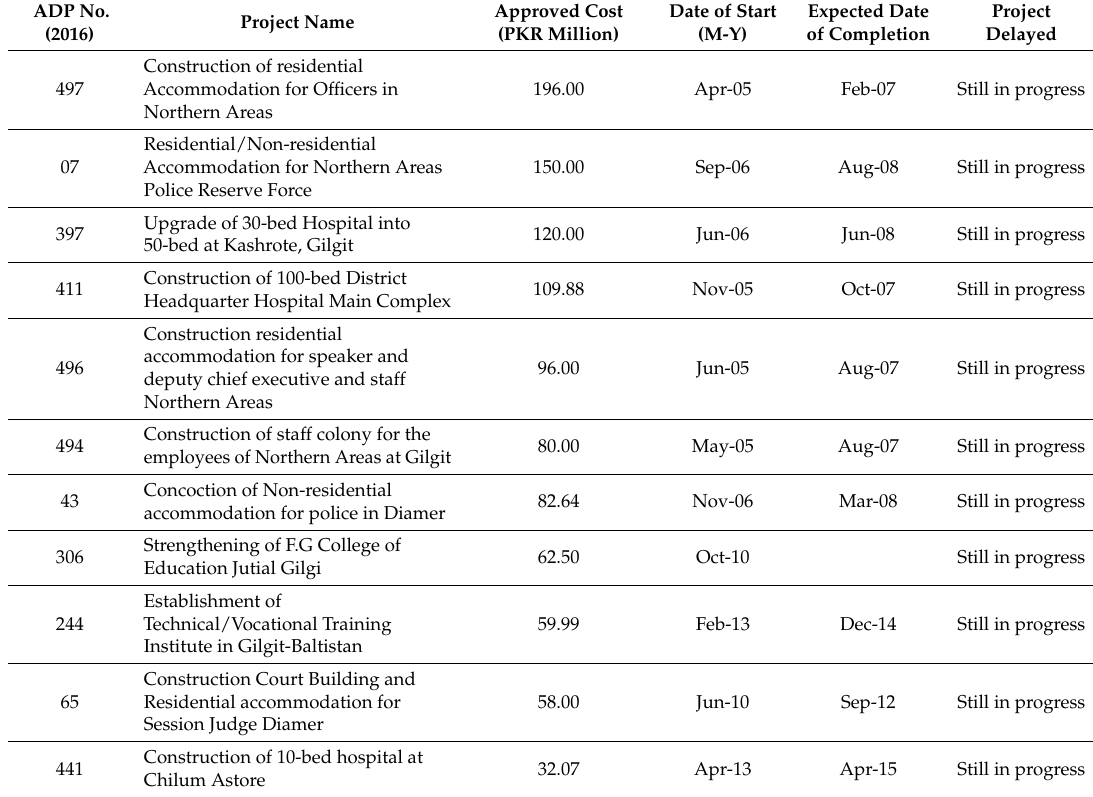
Table 1. Annual Development Programme (ADP) construction Projects Delay List in Gilgit-Baltistan (GB). ADP No.